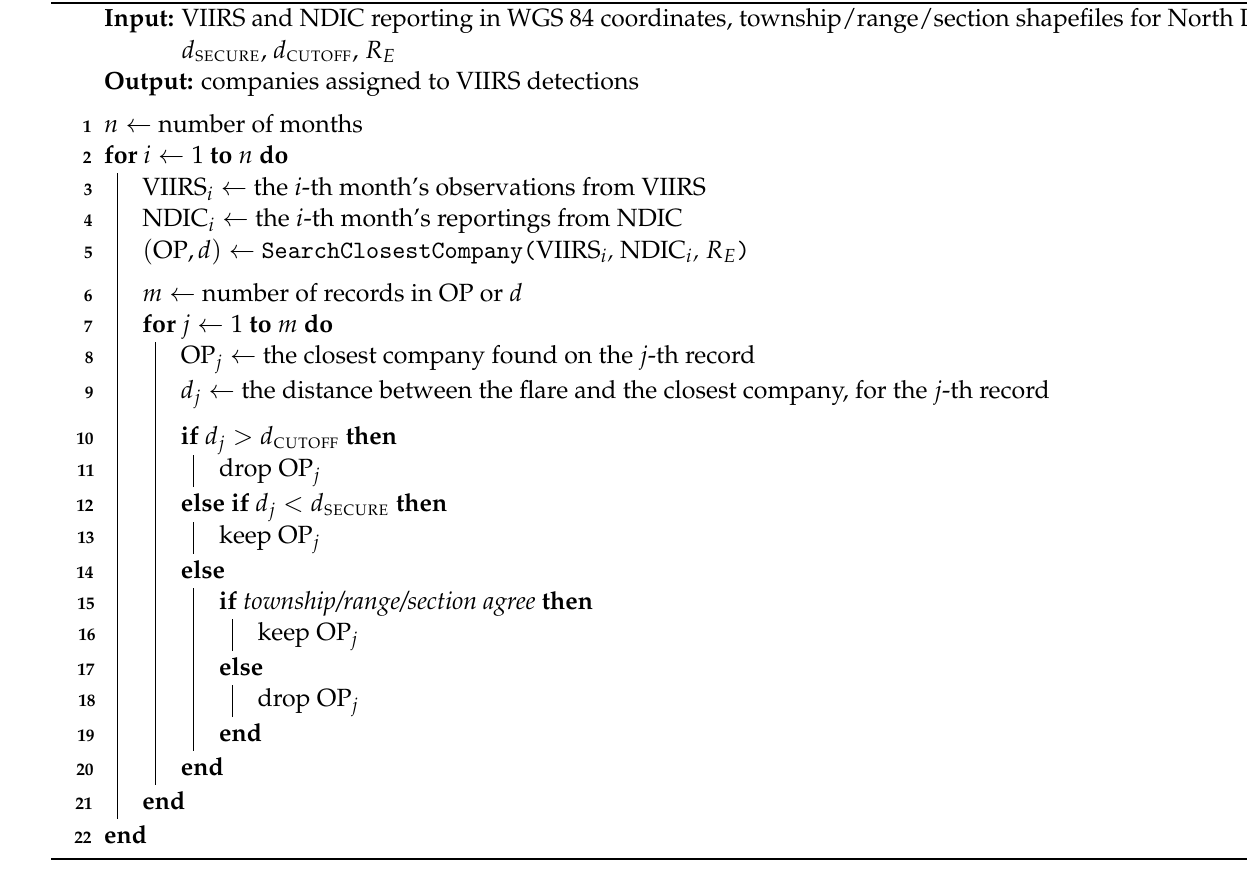
Algorithm 1: Nearest-Neighbor-Based Flare Owner